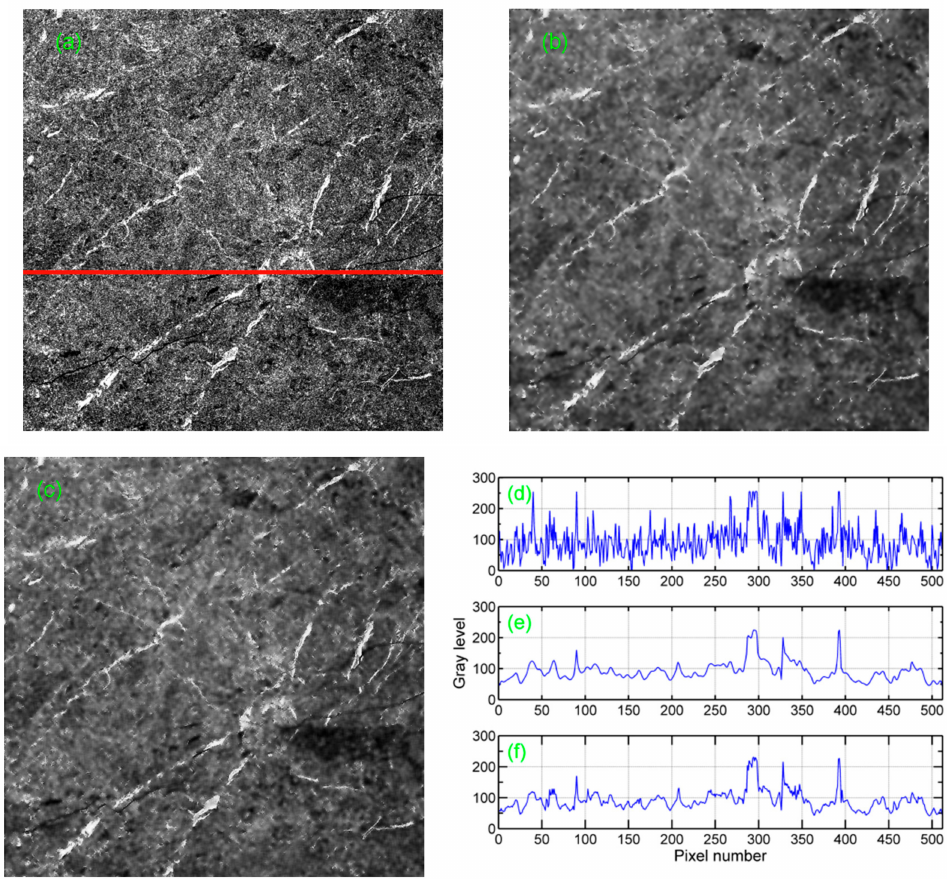
Figure 3. ( a ) Original SAR image, of size 512 × 512 pixels, we selected a row of SAR image data with a red line to compare the spatial luminance profile changes. ( b ) Filtered results with the SAR block-matching 3-D (SAR-BM3D) method. ( c ) Filtered results with the image despeckling convolutional neural network (ID-CNN) method. Spatial luminance profile changes at the red row of the SAR image: ( d ) Unfiltered SAR image, ( e ) filtered via SAR-BM3D method, and ( f ) filtered via ID-CNN